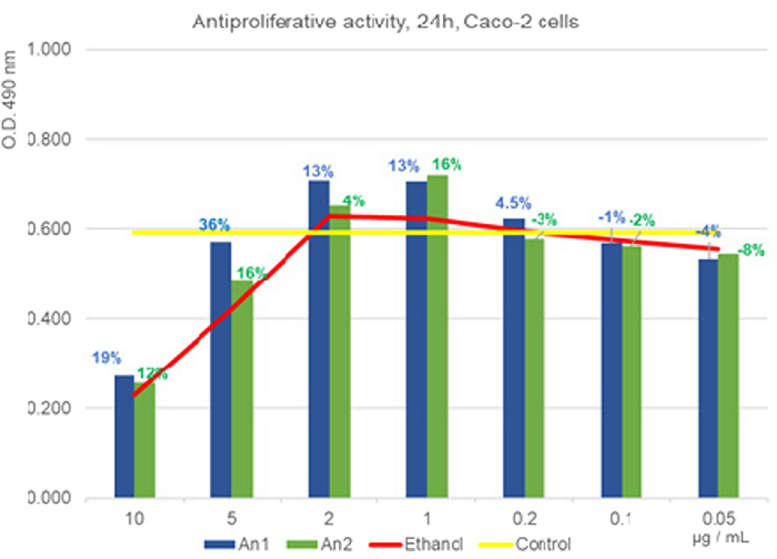
Figure 7: Caco - 2 cell antiproliferative test response after the treatment with the three - test samples ( An1, An2, and 40% ethanol dilution series ) in comparison with the control negative series, at 48 h.